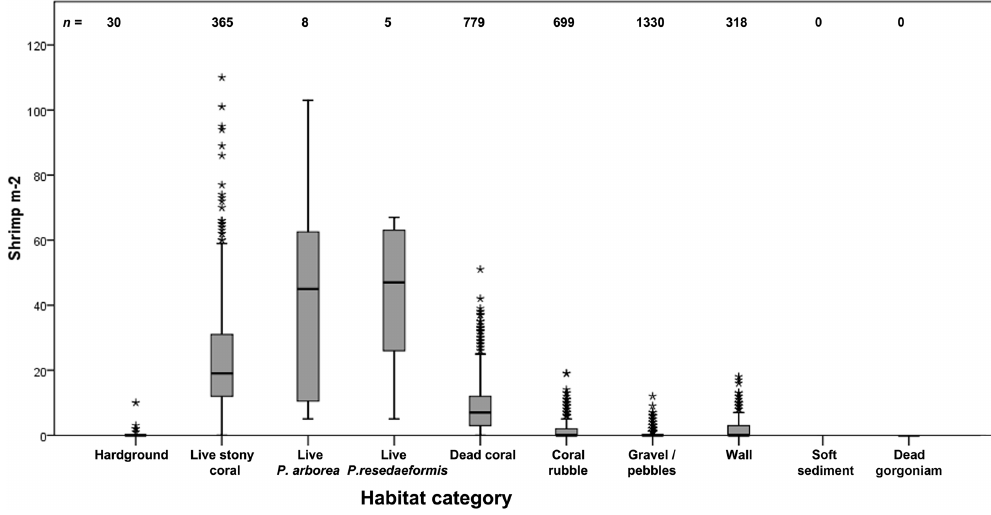
Fig. 6. Box plot showing observed median shrimp densities, quartiles and outliers observed in association with each of the investigated main microhabitat categories.